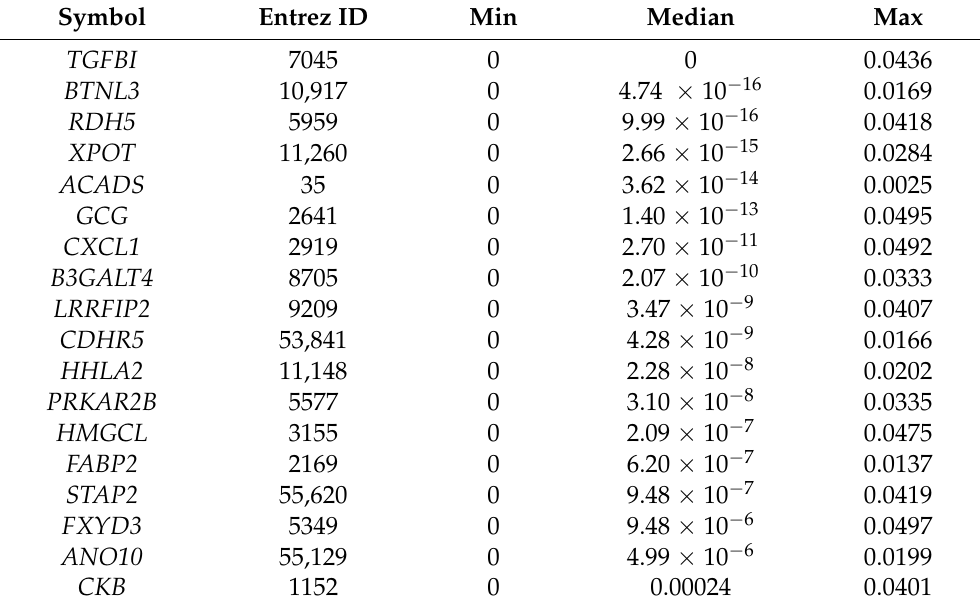
Table 2. The genes reported as significant in the 21 micro-array experiment analyzed using the beta distribution